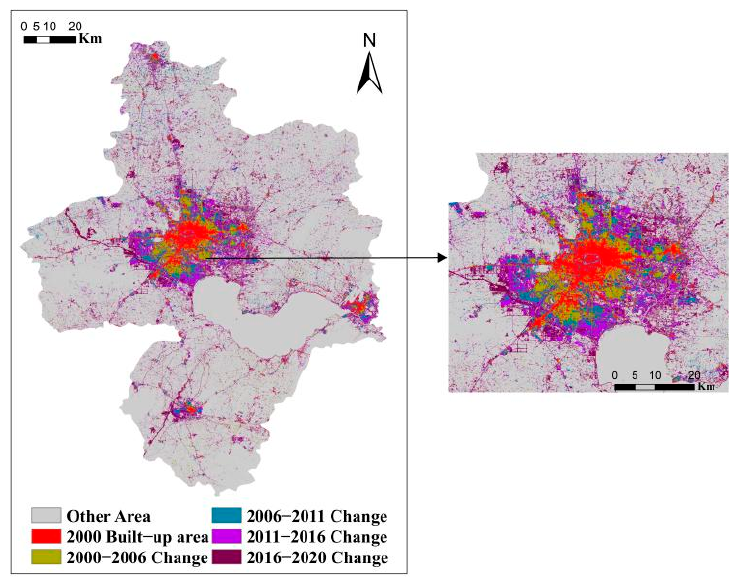
Figure 8. Change and characteristics of built-up area in Hefei from 2000 to 2020.